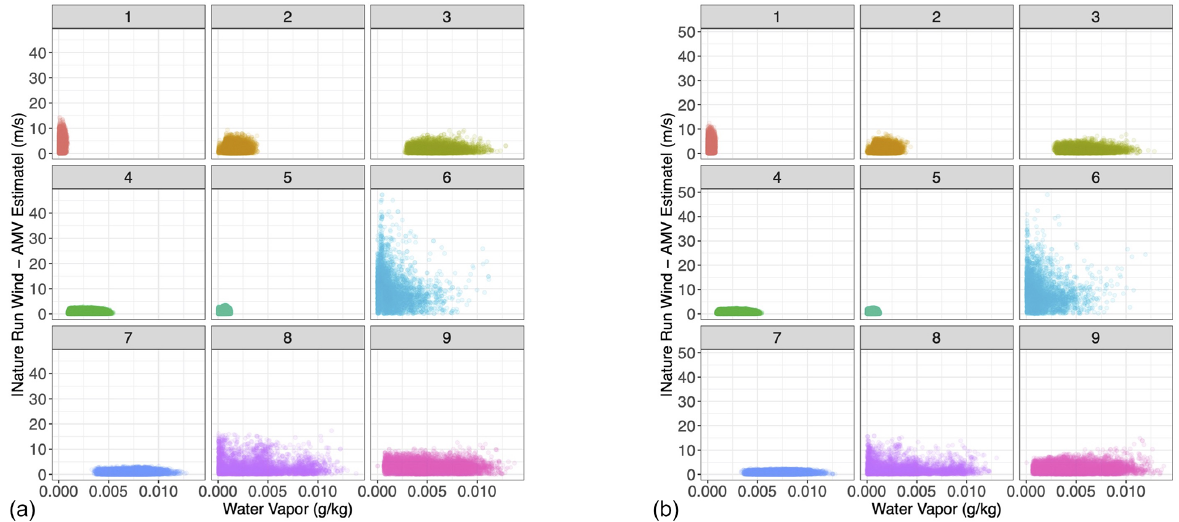
Figure 14. Water vapor vs. absolute tracked wind error, each sub-panel corresponding to the specific Gaussian mixture component to which each point in the testing set has been assigned when the Nature Run wind value has been substituted by the random estimate. (a) u -direction wind; (b) v -direction